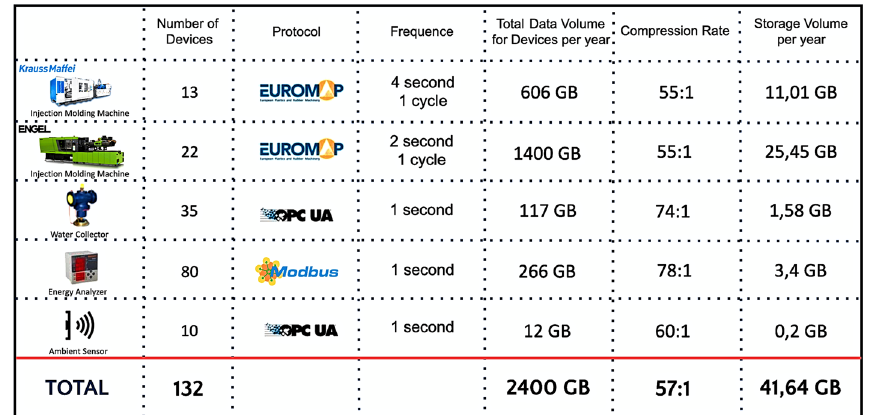
Fig. 5 Data transmission frequencies, streamed data volume, data transfer protocols, and device types are described in the table. There are two types of injection molding machines as KraussMaffei and Engel. Data frequencies are different because of machine specifications. Data compression rates differ according to data types and average of the compression rate is 59:1. Thanks to the compression process, 19GB storage resource is used instead of